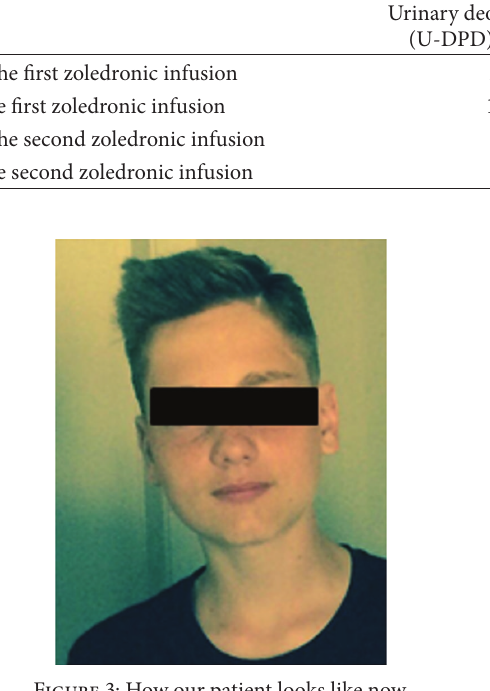
Figure 3: How our patient looks like